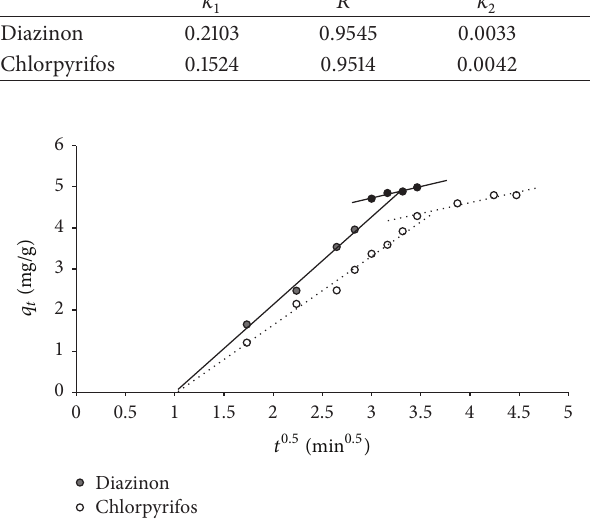
Table 1: Comparison of kinetic parameters for the adsorption of diazinon and chlorpyrifos by TNP. Poisons